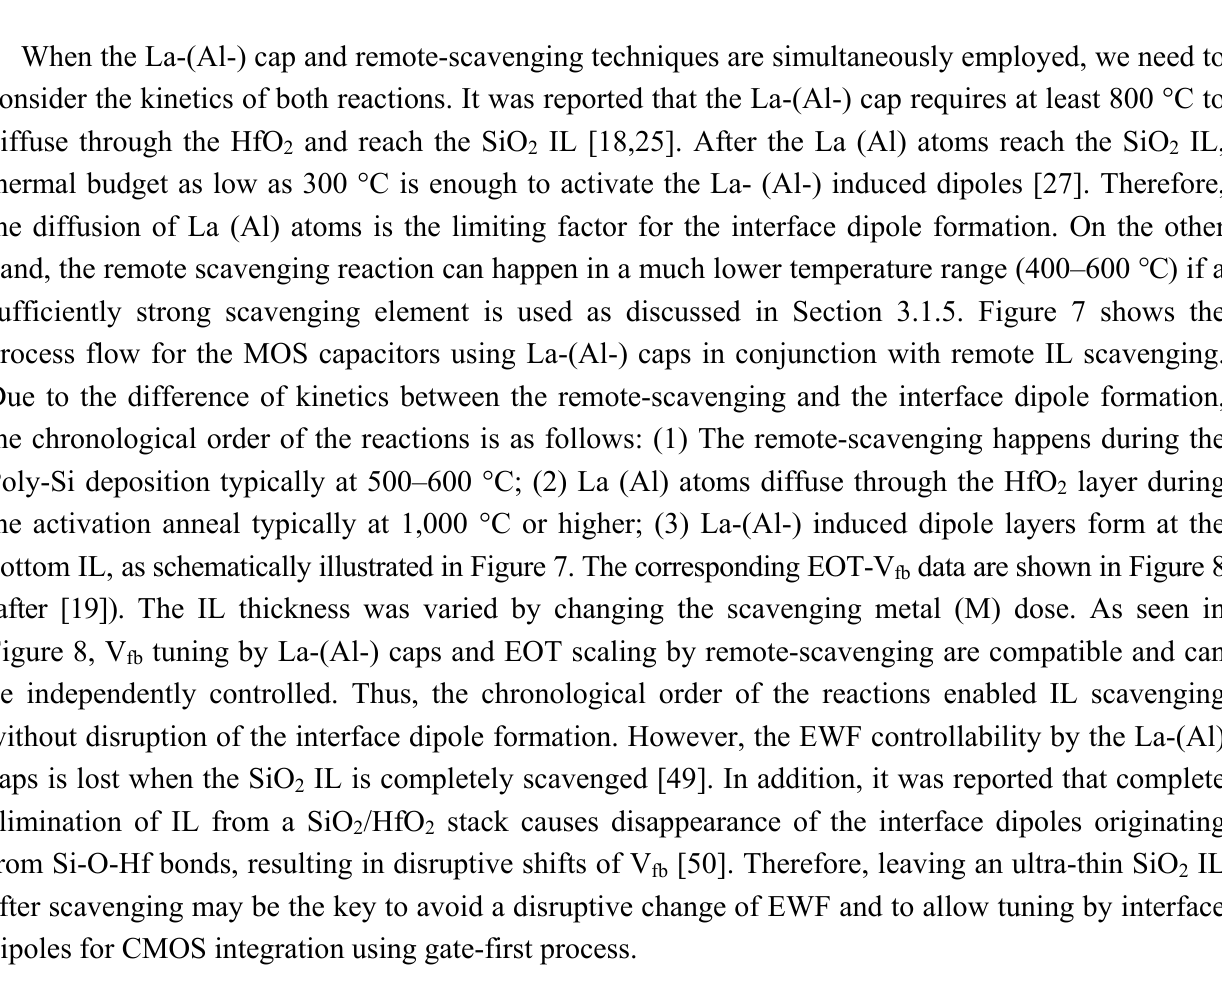
Figure 7. Process flow for MOS capacitors using La-(Al-) caps in conjunction with remote IL scavenging. The change in the gate dielectrics at the key steps is illustrated in the schematics. The corresponding electrical data are shown in Figure